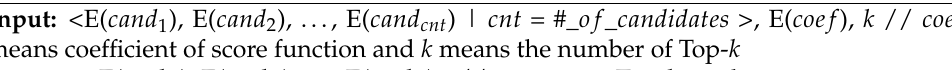
Algorithm 8 Parallel Top- k retrieval